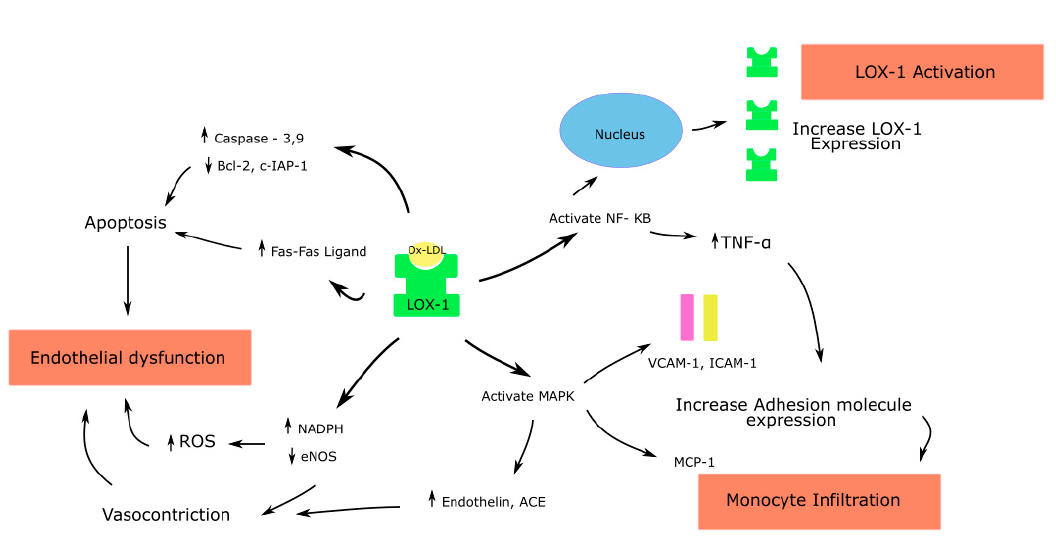
Figure 1. Effects of Ox-LDL–LOX-1 interaction in endothelial cells; ROS—Reactive oxygen species; endothelial nitric oxide synthase—eNOS; Nuclear factor kappa-light-chain-enhancer of activated B cells—NF- κ B; Mitogen activated protein kinase—MAPK; Angiotensin converting enzyme—ACE; Monocyte chemoattractant protein—MCP; Tumor necrosis factor—TNF.